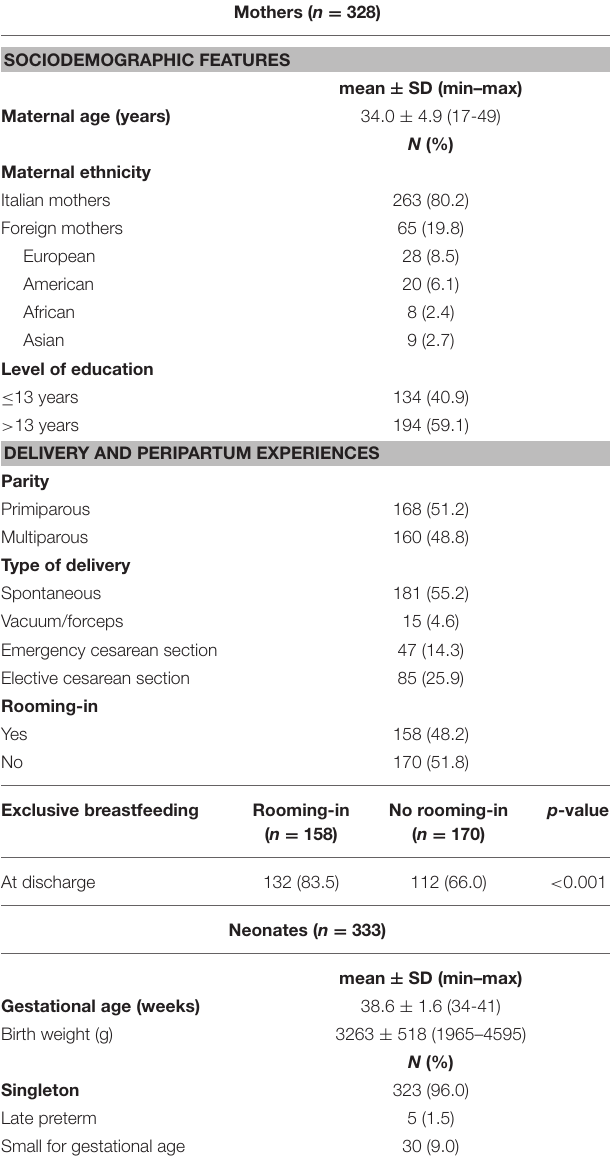
TABLE 2 | Basic characteristics of mothers and